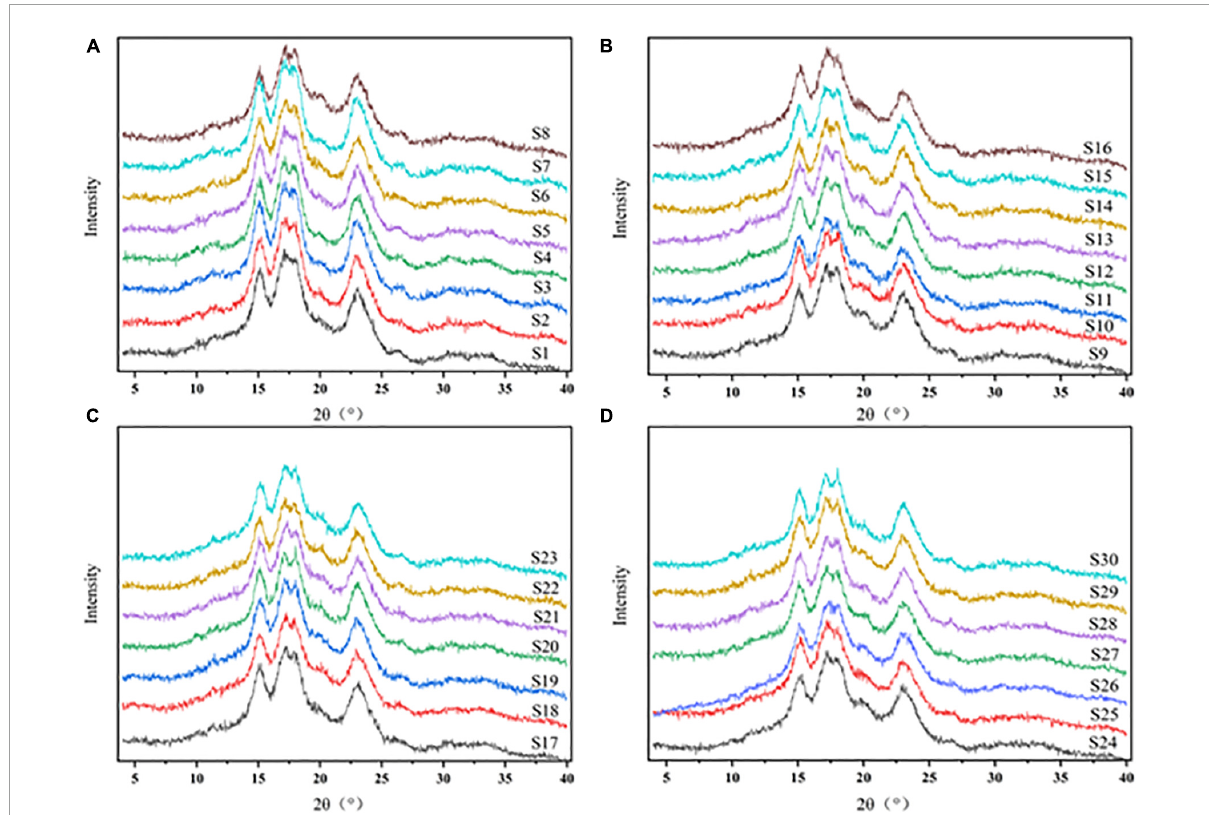
FIGURE5 (A) X-ray diffraction from S1 to S8. (B) X-ray diffraction from S9 to S16. (C) X-ray diffraction from S17 to S23. (D) X-ray diffraction from S24 to